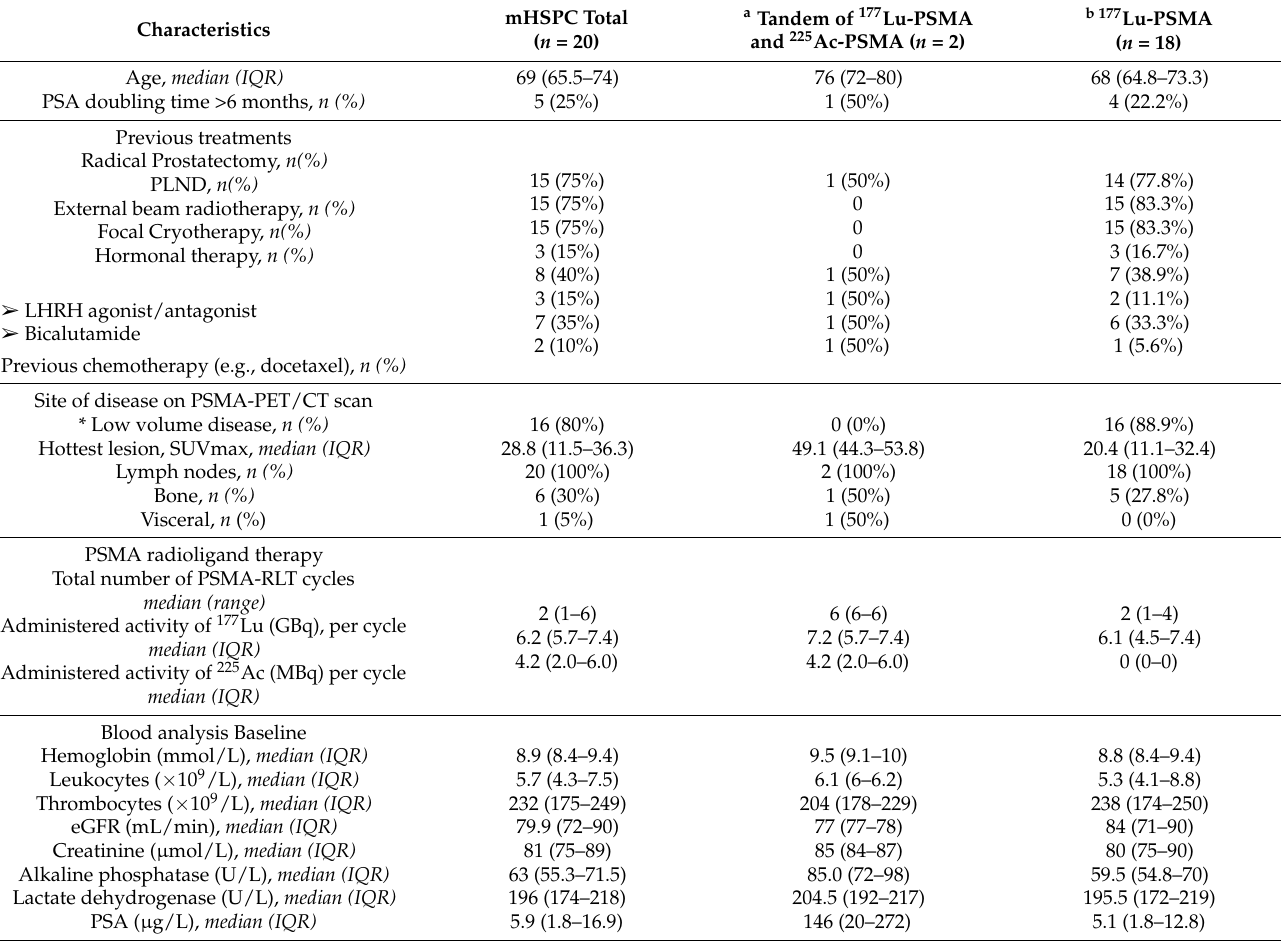
Table 1. Baseline